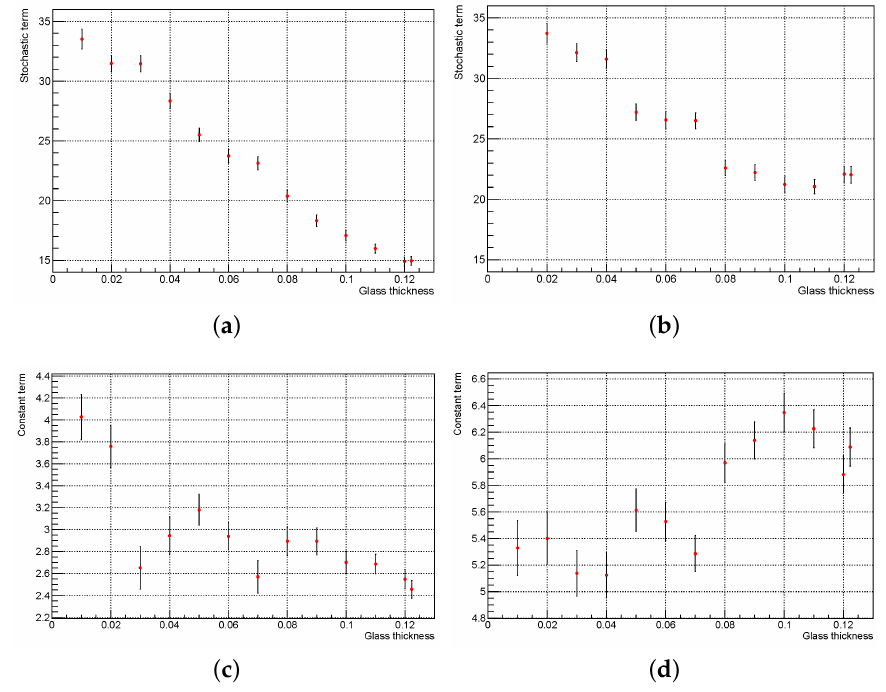
Figure 5. Stochastic and constant terms of hadronic energy resolution versus the thickness of scintillating glass with different energy thresholds. ( a ) Stochastic term with the threshold = 0 MIP; ( b ) stochastic term with the threshold = 0.3 MIP; ( c ) constant term with the threshold = 0 MIP; ( d ) constant term with the threshold = 0.3